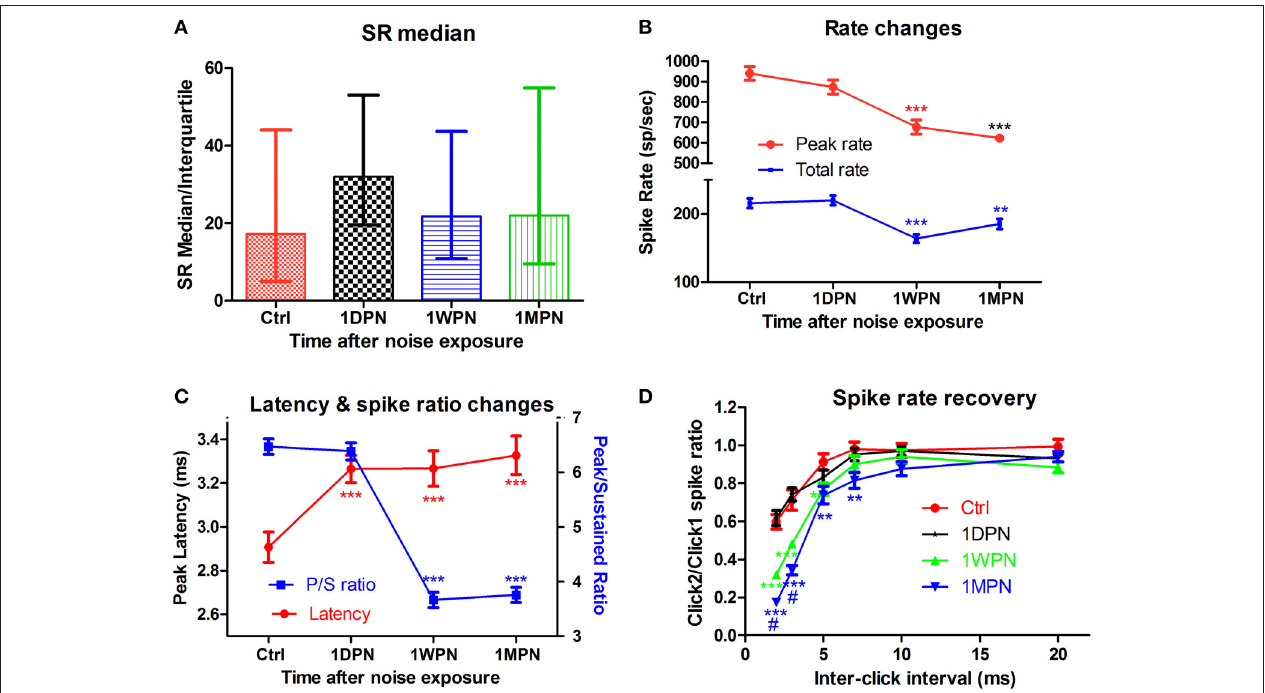
FIGURE 2 | Impact of noise on single unit activity of ANFs. (A) The transient change of SR in high frequency region (beyond 4kHz). (B) Decrease in both peak and total spike rate. (C) Prolonged peak latency and decreased peak/sustained spike ratio. (D) Normalized recovery of spike rate evoked by the 2nd click as a function of inter click interval, showing delayed recovery in damaged cochleae. Tests in (B–D) are all from low-SR units ( ** p < 0.01 and *** p < 0.001 , respectively, for comparisons against Ctrl; # p < 0.05 against